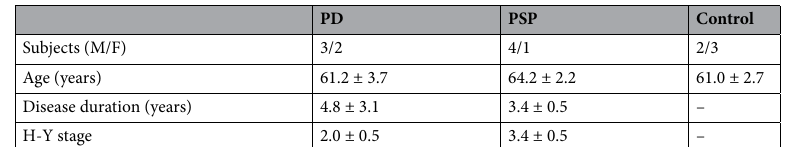
Table 2. Demographic and clinical characteristics of PD, PSP, and healthy control groups. Data are shown as mean ± standard deviation. Control = healthy control; H-Y = Hoehn & Yahr; PD = Parkinson’s disease; PSP = progressive supranuclear